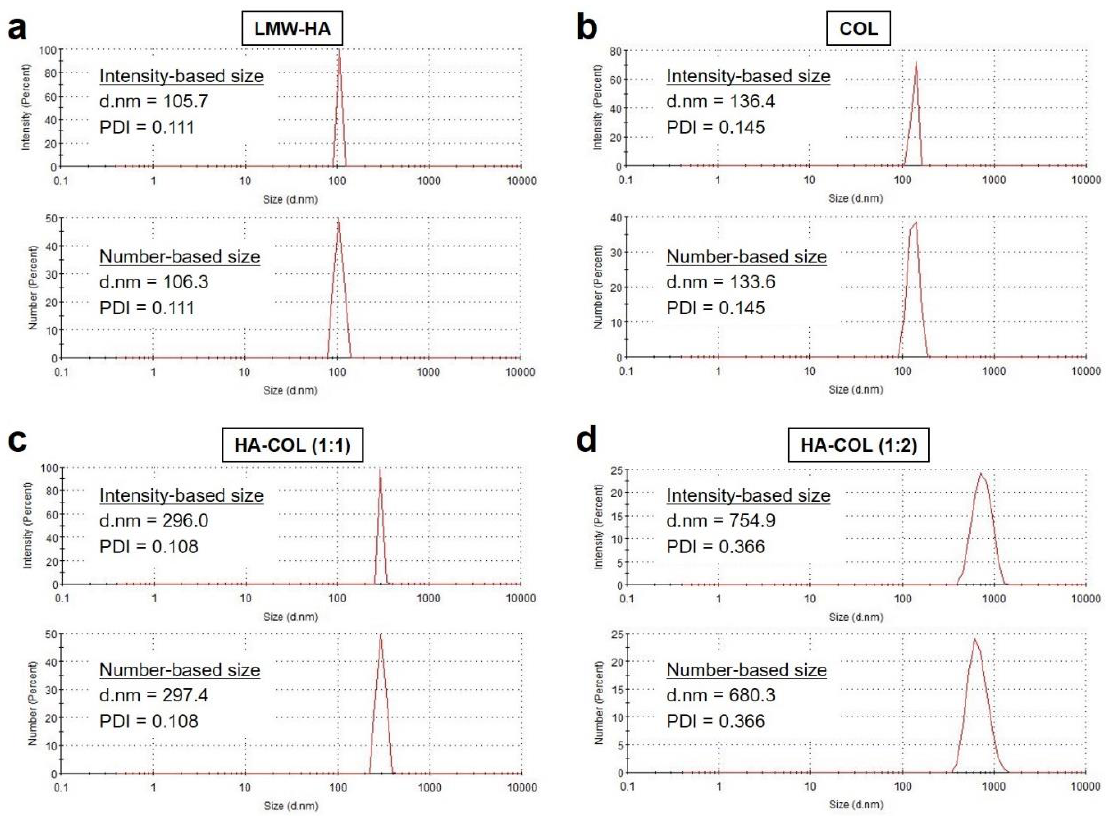
Figure 3. Size distributions of ( a ) LMW-HA, ( b ) COL, ( c ) HA-COL (1:1), and ( d ) HA-COL (1:2) before and after formation of nanocomplexes. The HA-COL nanocomplexes were prepared at varying molar ratios from 1:1 to 1:2 (LMW-HA:COL).